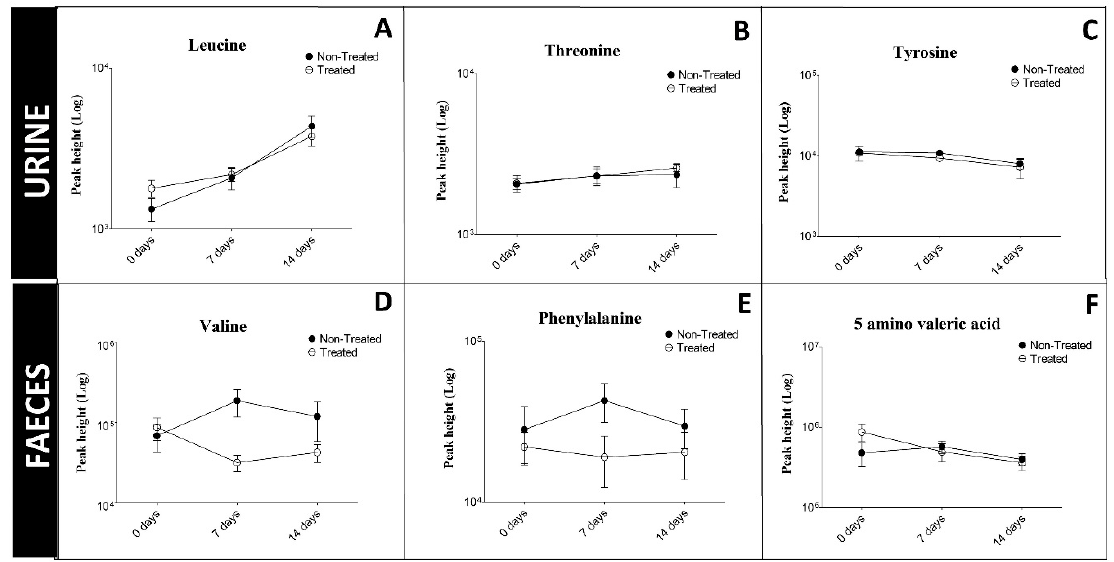
Figure 6. Changes of urinary biomarkers ( A ) leucine, ( B ) threonine, ( C ) tyrosine and faecal biomarkers ( D ) valine, ( E ) phenylalanine, ( F ) 5 amino valeric acid during treatment of animals with benztropine. Female C57BL/6J mice were provided with chow containing 1.25 mg benztropine/5 g or received normal chow. Urine and faecal samples were taken before treatment and after 7 and 14 days of treatment.